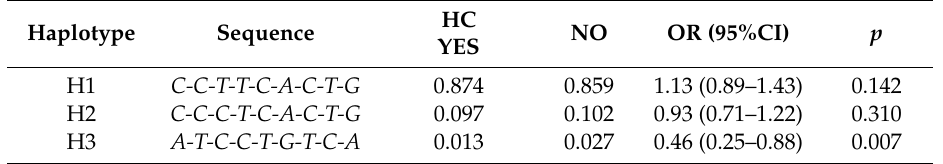
Figure 1. Linkage disequilibrium analysis. Delta (D’) and r 2 values are shown. Table 3. Haplotype frequencies in individuals with and without HC.